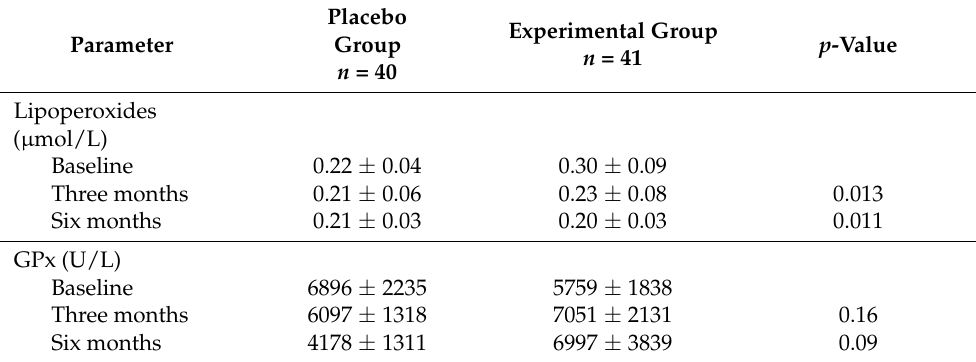
Table 3. Pre- and post-treatment oxidative stress markers by study group.